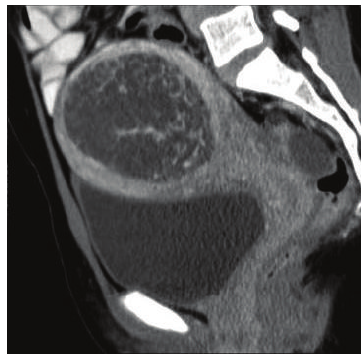
Figure 7: Sagittal reformation of contrast enhanced CT in a patient with complete hydatiform mole shows a large low attenuation, central uterine mass with intact surrounding myometrium.